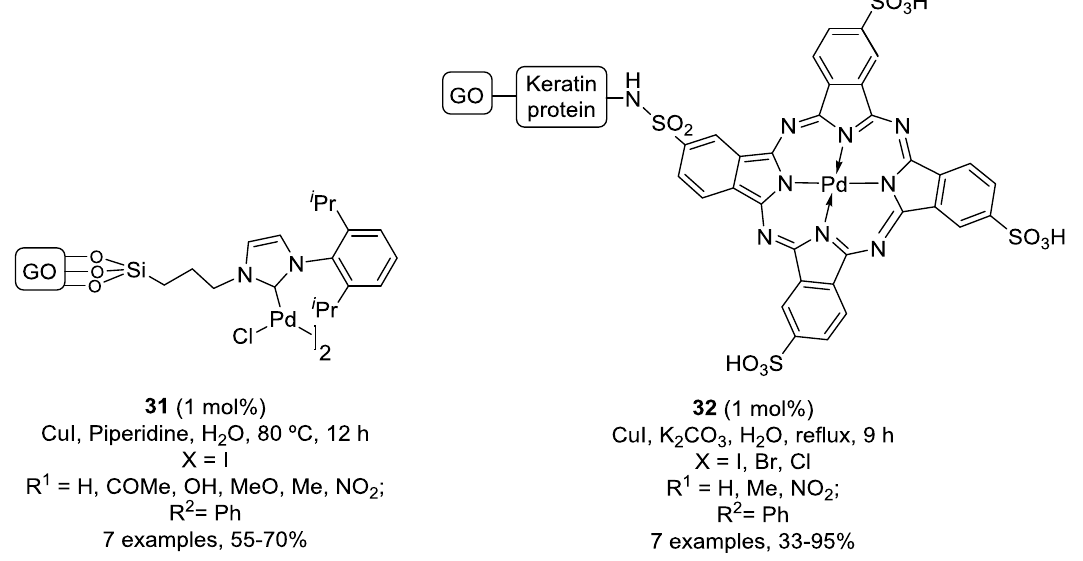
Figure 11. Palladium species immobilized on functionalized graphene oxide as catalysts for the Sonogashira reaction. Conditions, substrate scope and yield range (Scheme 2).